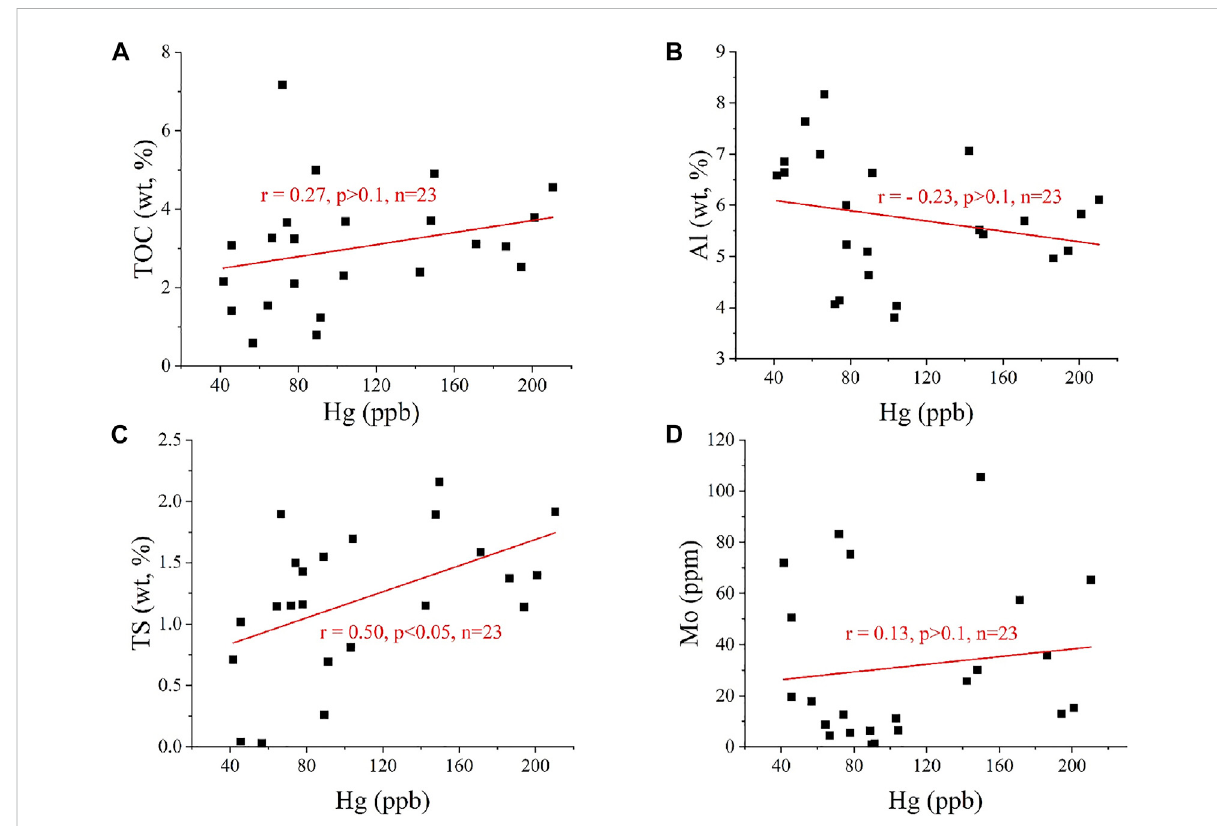
FIGURE 9 Crossplots of Hg with (A) TOC, (B) Al, (C) TS, and (D)